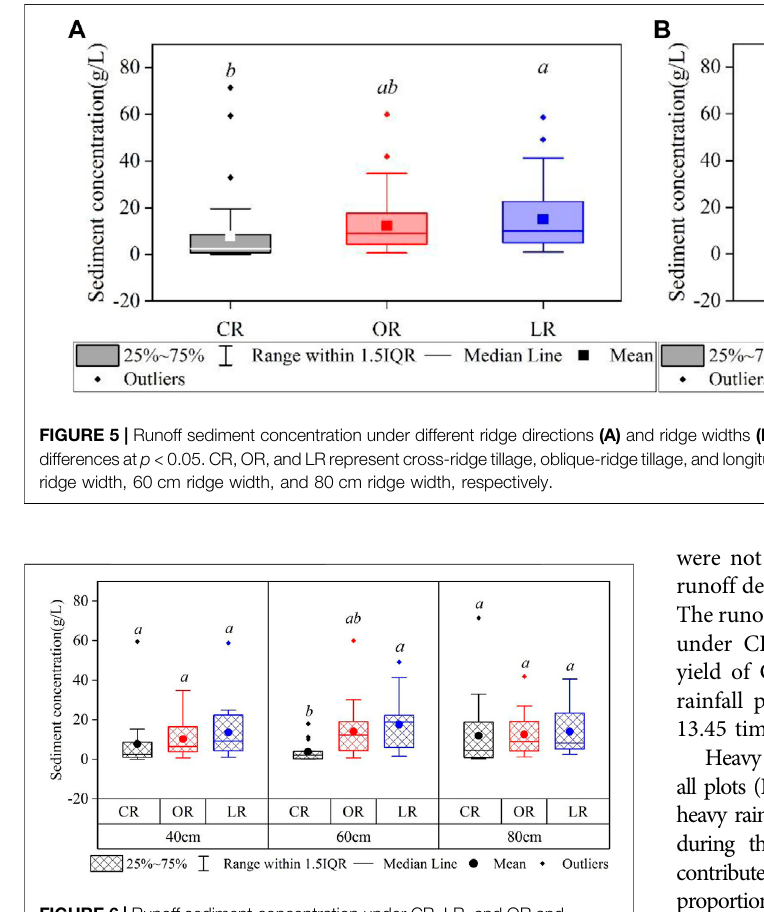
Frontiers in Earth Science |